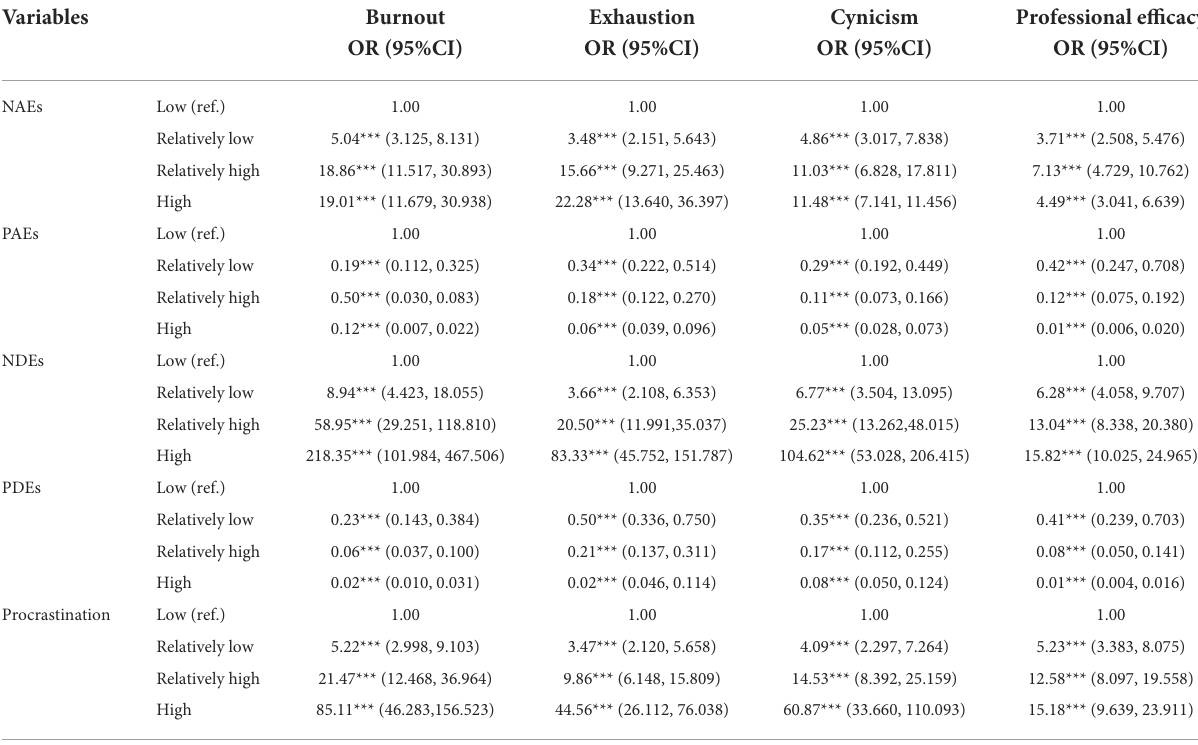
TABLE 4 The relations of burnout, delay and GAEs by using binary logistic regressions.